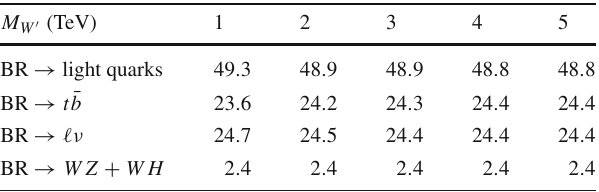
Table 1 W (cid:2) branching ratios in per cent for ξ W − W (cid:2) = ( M W / M W (cid:2) ) 2 M W (cid:2)